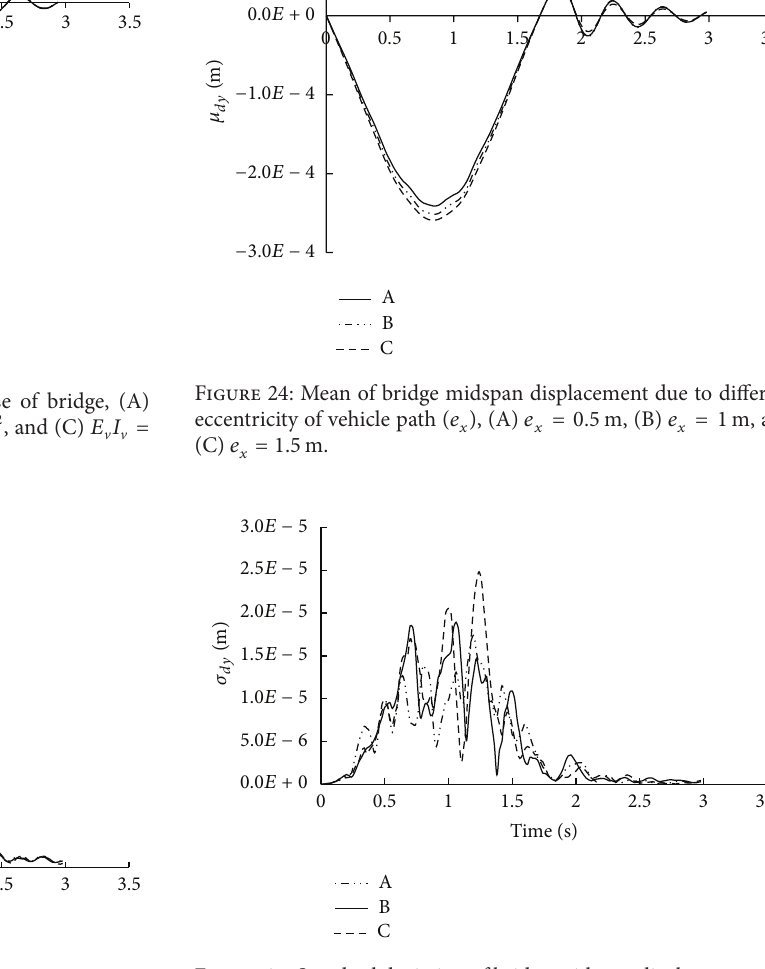
Figure 25: Standard deviation of bridge midspan displacement due to different eccentricity of vehicle path (𝑒 𝑥 ) , (A) 𝑒 𝑥 = 0.5 m, (B) 𝑒 𝑥 = = 1.5 1 m, and (C) 𝑒 𝑥